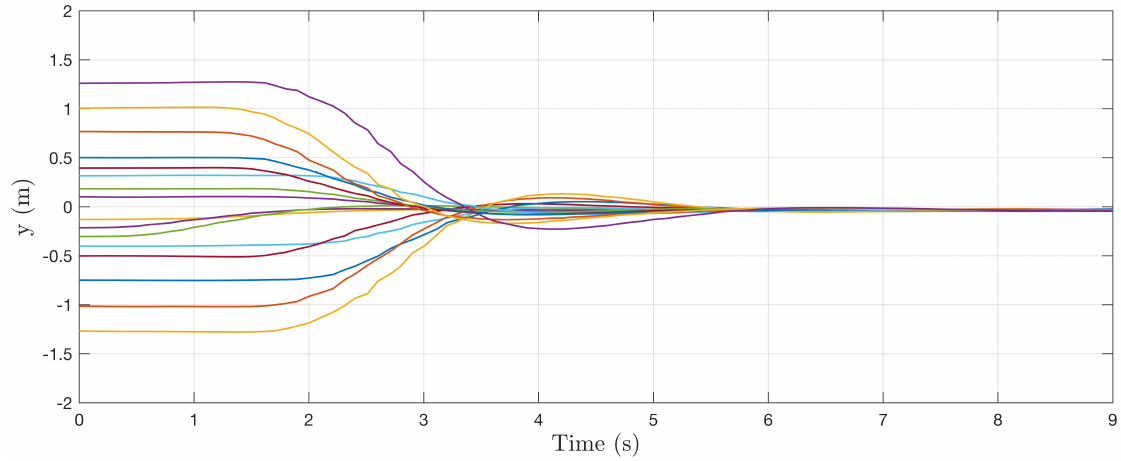
Figure 9. Collection of system responses to a nonzero initial lateral state. Each line represents a different trajectory with a unique nonzero initial perturbation to lateral position.